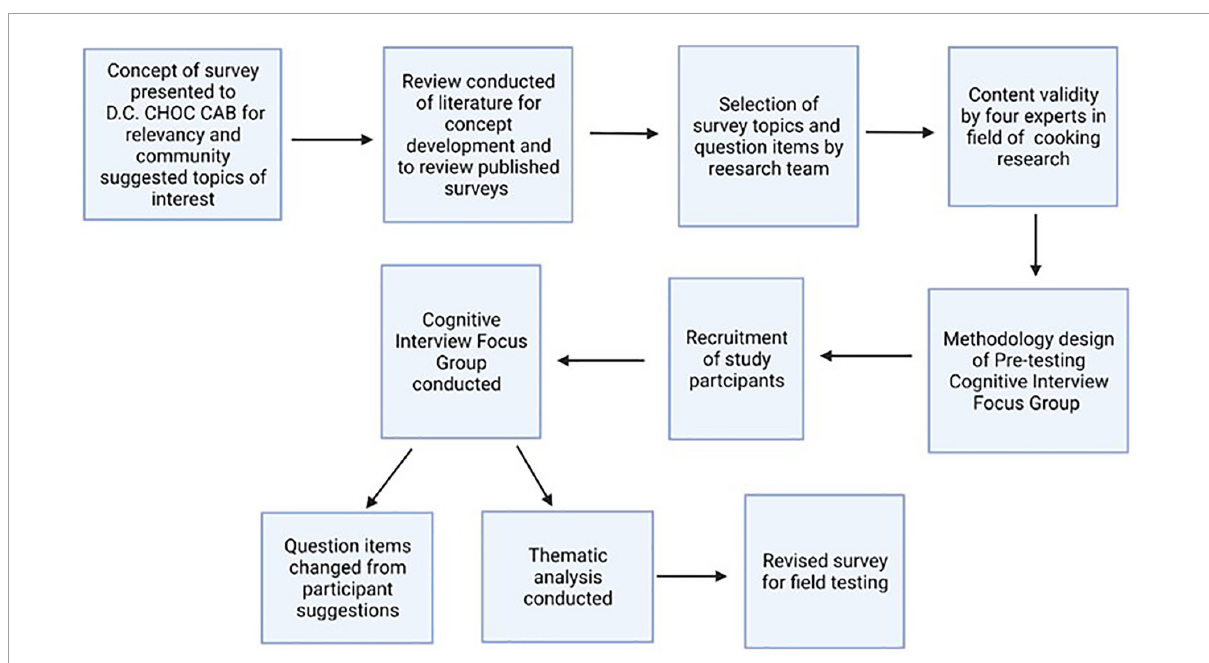
FIGURE1 Schema of survey instrument development. Survey instrument development using cognitive focus group pretesting design. D.C. CHOC, D.C. Cardiovascular Health and Obesity Collaborative; CAB, community advisory